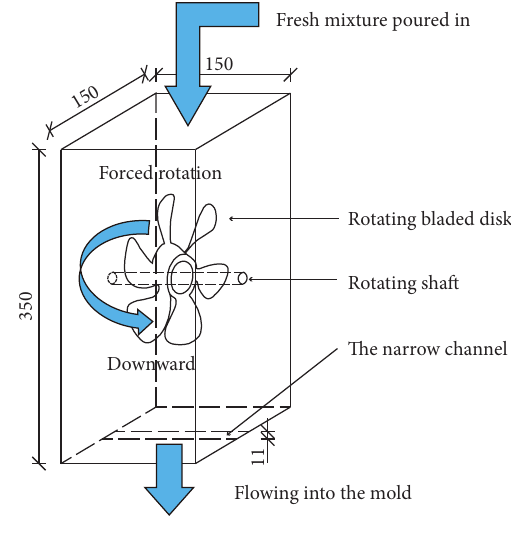
Figure 2: Steel fiber directional arrangement device (unit: